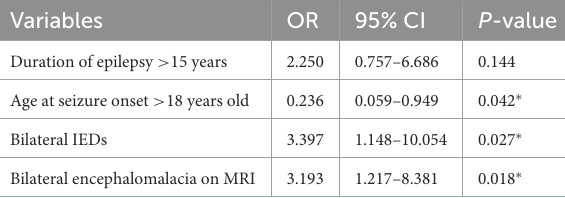
TABLE 3 Predictors of VNS effectiveness for pharmacoresistant epilepsy secondary to encephalomalacia on multivariate analysis.